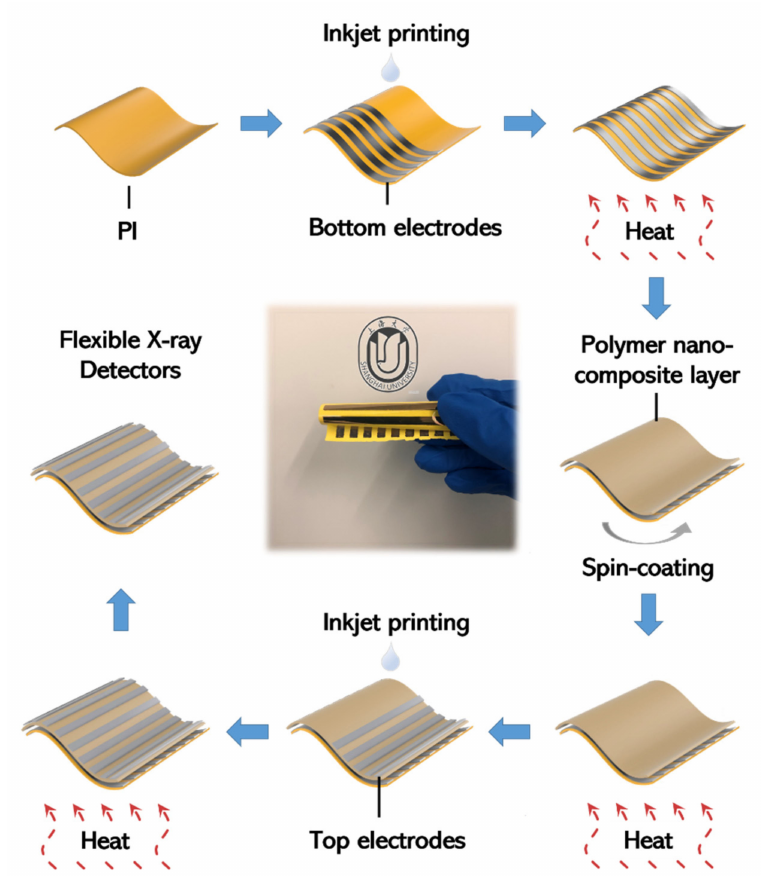
Figure 1. The schematic diagram of the device fabrication. Bottom electrodes The PI was cleaned with deionized water for 10 min and dried with compressed air before using. The bottom electrodes were printed on the PI